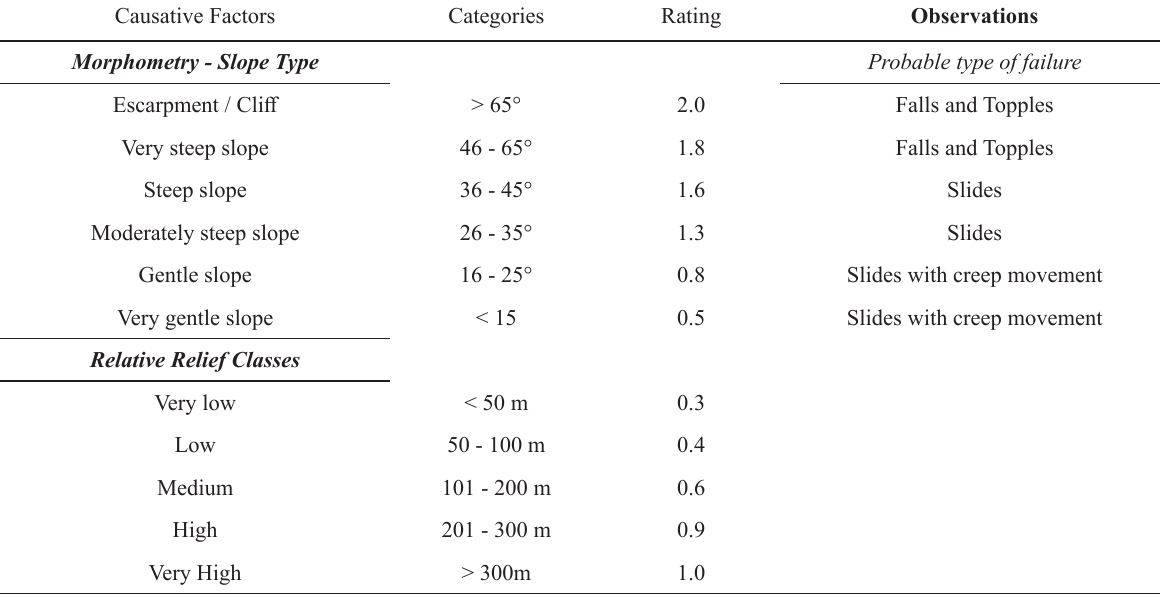
Ratings for Slope Morphometry and Relative Relief (Anbalagan 1992, Anbalagan et al. 2008). Causative